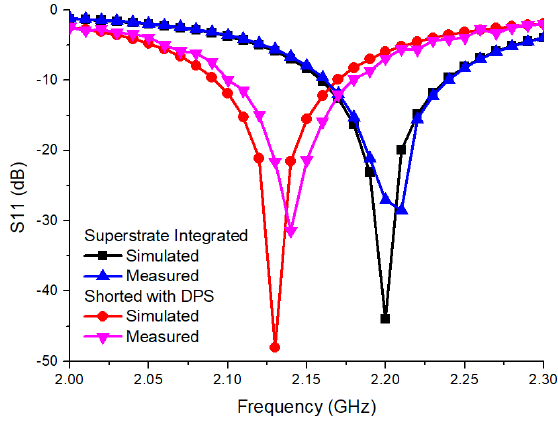
Figure 13. Simulated and measured S11 parameter of antenna element and superstrate integrated antenna.